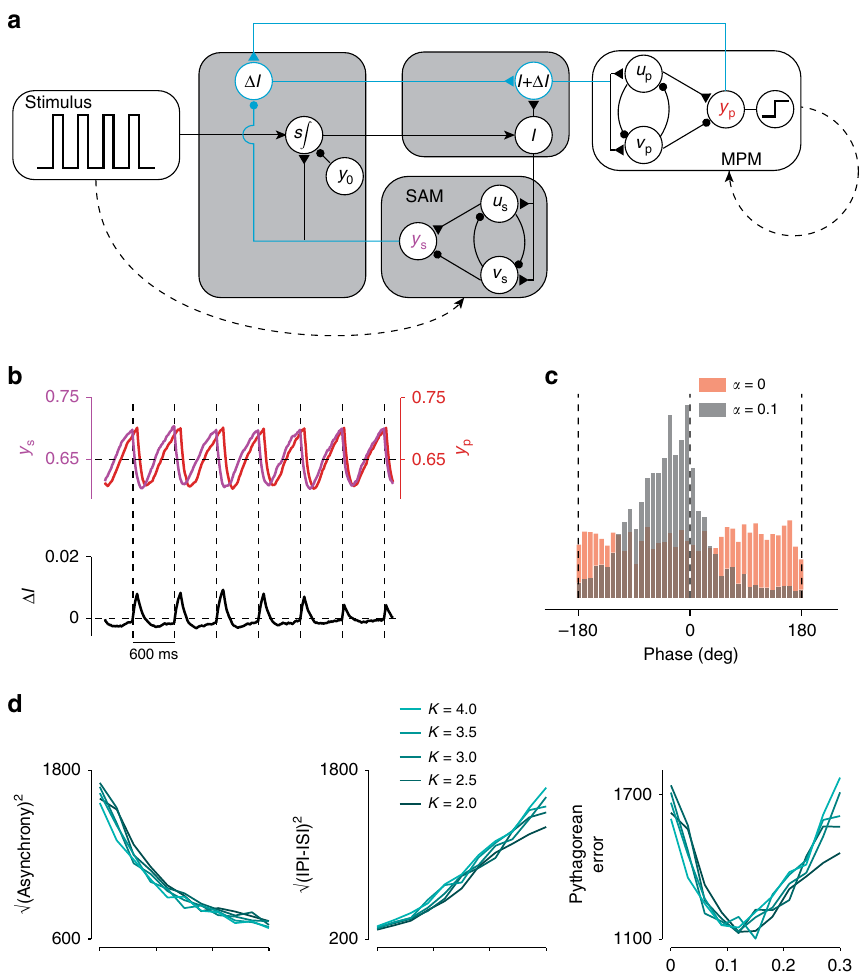
Fig. 5 Full circuit model for synchronization. a Augmented circuit model. To synchronize the MPM with SAM output, a second circuit pathway was introduced to measure the difference between these two outputs. The difference, weighted by α , augments the input to the MPM with input Δ I . b MPM output, y p , SAM output, y s , and their difference weighted by α = 0.1 (i.e. Δ I = α ( y p − y s )). Augmenting I with Δ I adjusts controller output to the MPM such that the time of production tends to match the time of fl ashes (vertical dashed lines). c Distribution of the phase of production for the circuit with (black) and without (red) augmented input. d Optimization of α . Increasing α decreases asynchrony (left; as de fi ned in the Methods). In contrast, increasing α increases the sum of the squared IPI errors (middle). As a result, a limited range of α values minimize Pythagorean errors, de fi ned as ffiffiffiffiffiffiffiffiffiffiffiffiffiffiffiffiffiffiffiffiffiffiffiffiffiffiffiffiffiffiffiffiffiffiffiffiffiffiffiffiffiffiffiffiffiffiffiffiffiffiffiffiffiffiffiffiffiffiffi q ð IPI (cid:2) ISI Þ 2 þ ð Asynchrony Þ 2